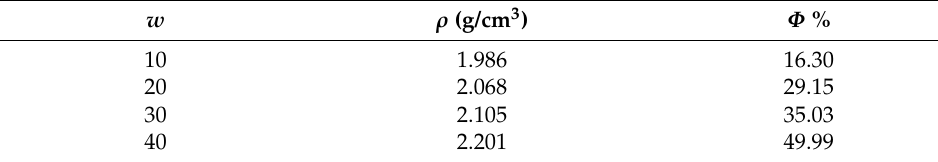
Table A1. The parameters of PFPE oil-based